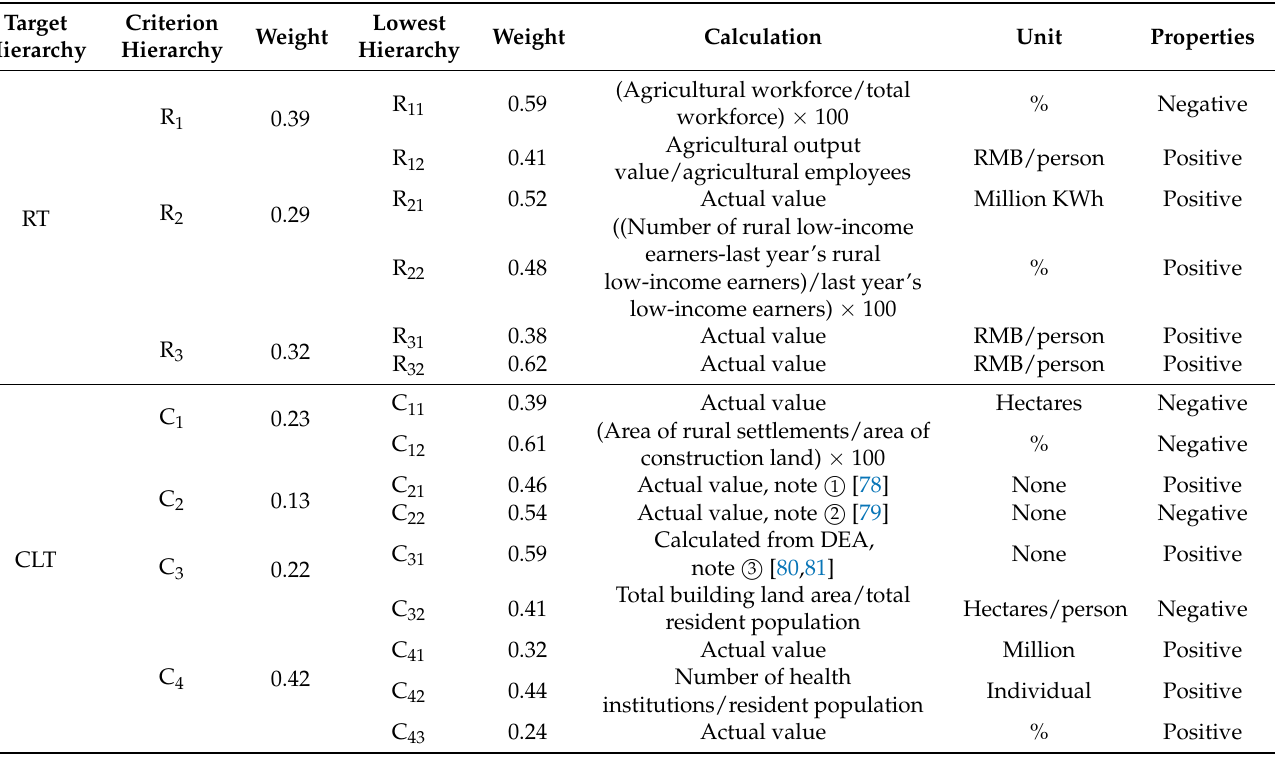
Table 1. Weight value of the evaluation index for RT and CLT.